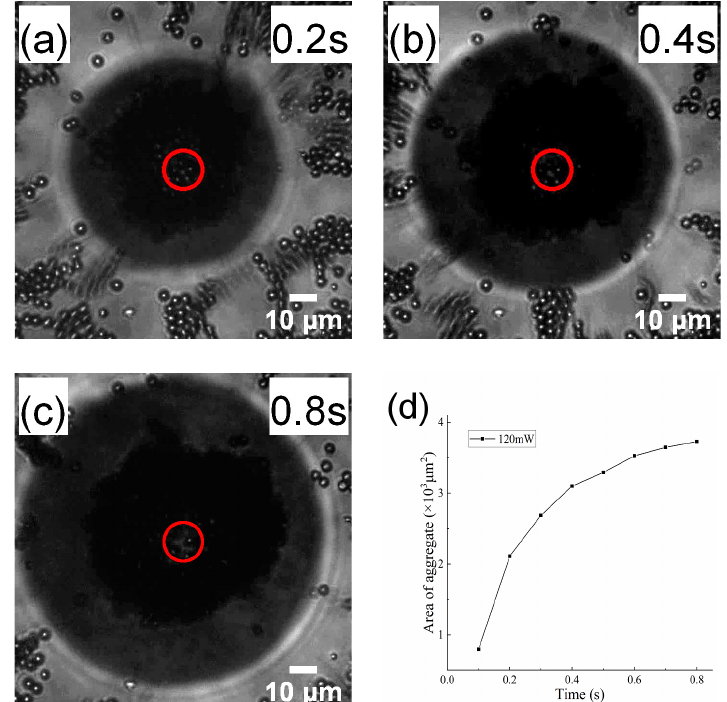
Figure 6. ( a – c ) Images of bubble-assisted forming of AP aggregates. The red circle indicates the laser focus. Scale bar, 10 µ m. ( d ) Areas of AP aggregates as a function of laser irradiation time. The laser power was 120 mW at the pupil of the objective. The thickness of suspension layer was 70 µ